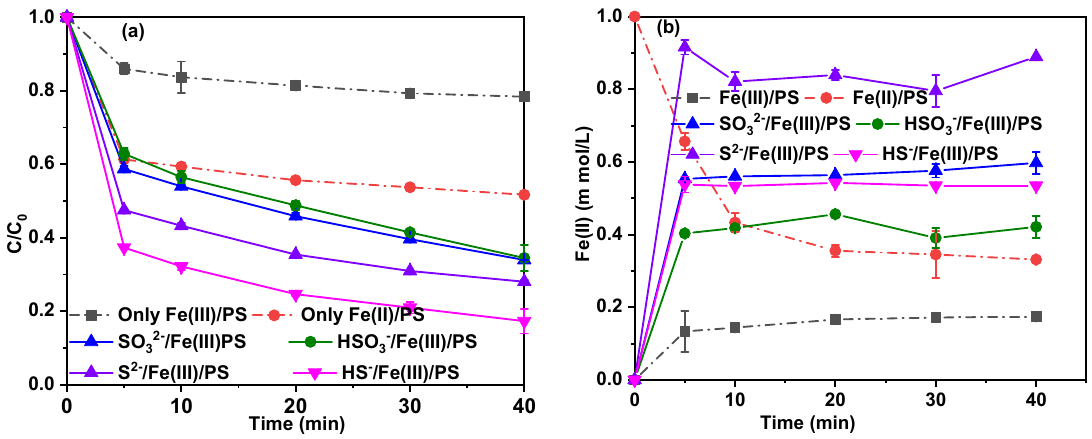
Figure 1. BPA removal in different systems ( a ); Concentration of regenerated Fe(II) in different systems ( b ). Reaction conditions: [Fe(III)] = 1.0 mM, [S(-II)] = [S(IV)] = 1.0 mM, [PS] = 4 mM, [BPA] = 10.0 mg/L.